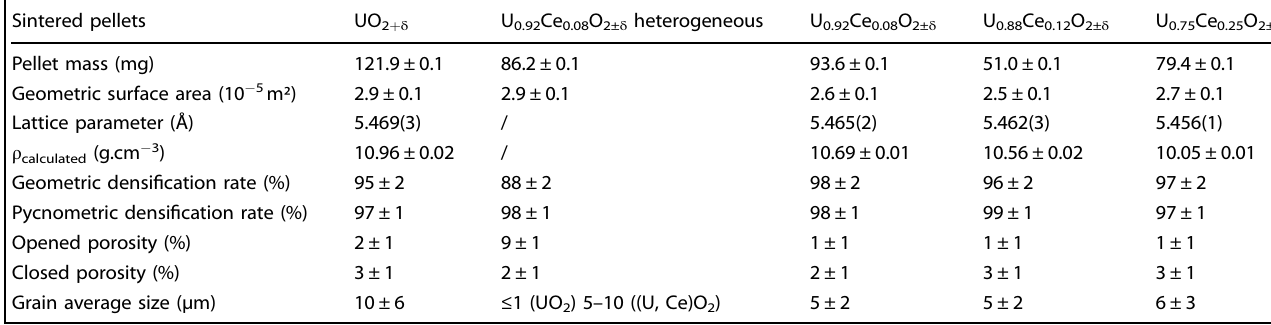
Table 2. Sintered pellets properties after sintering at 1600 °C under Ar-H 2 4.5% for several hours. Sintered